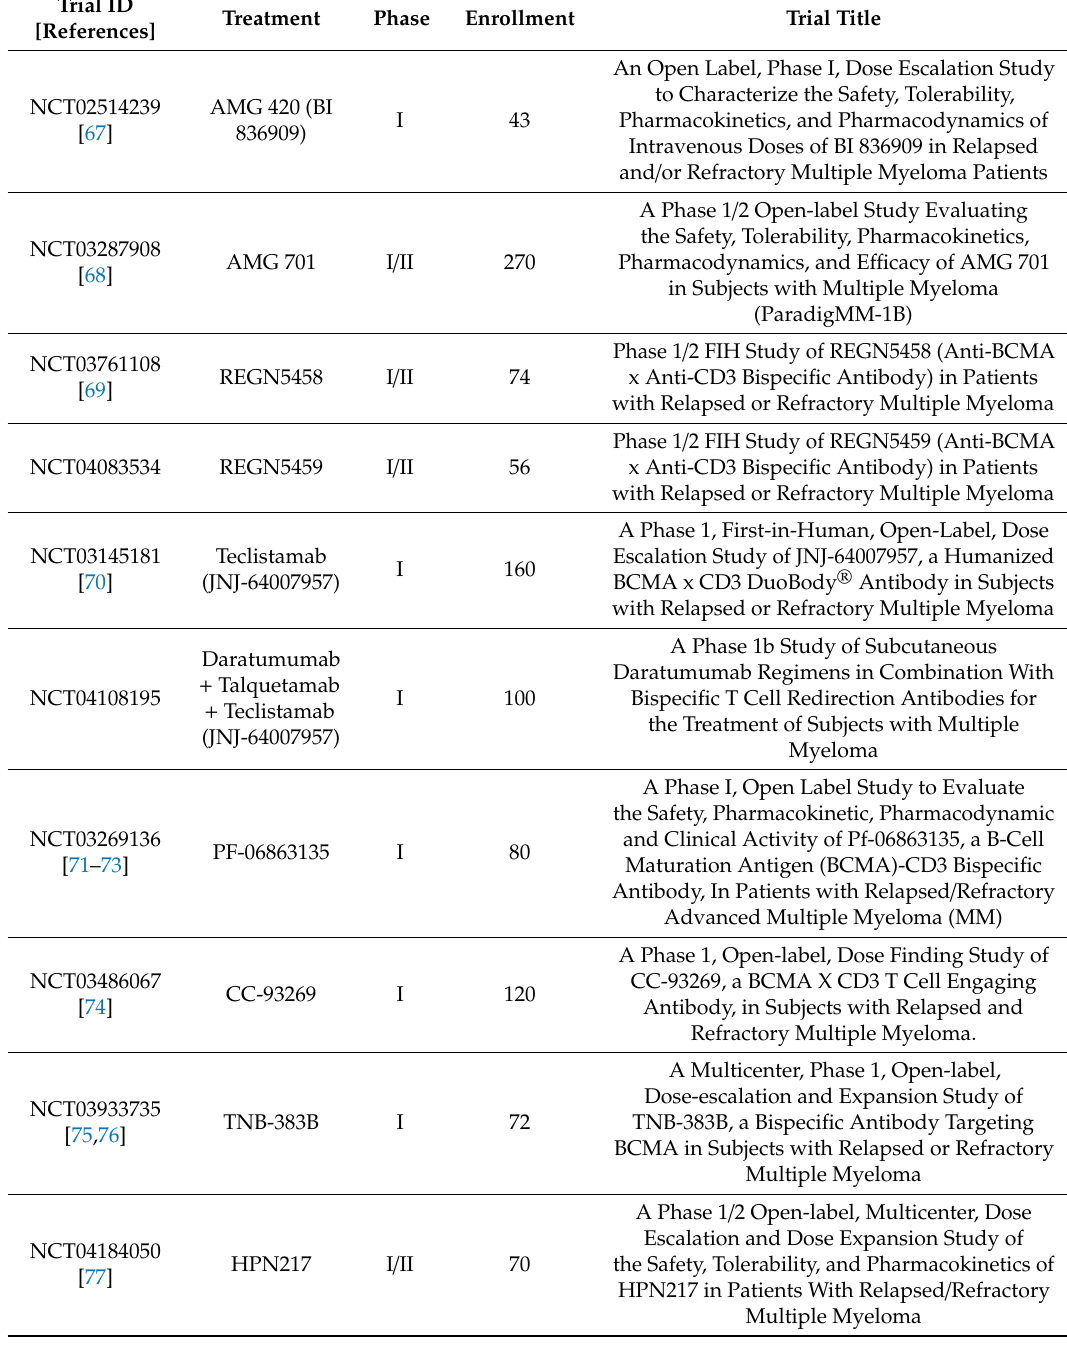
Table 2. Active trials of T-cell-engaging bispecific antibodies in